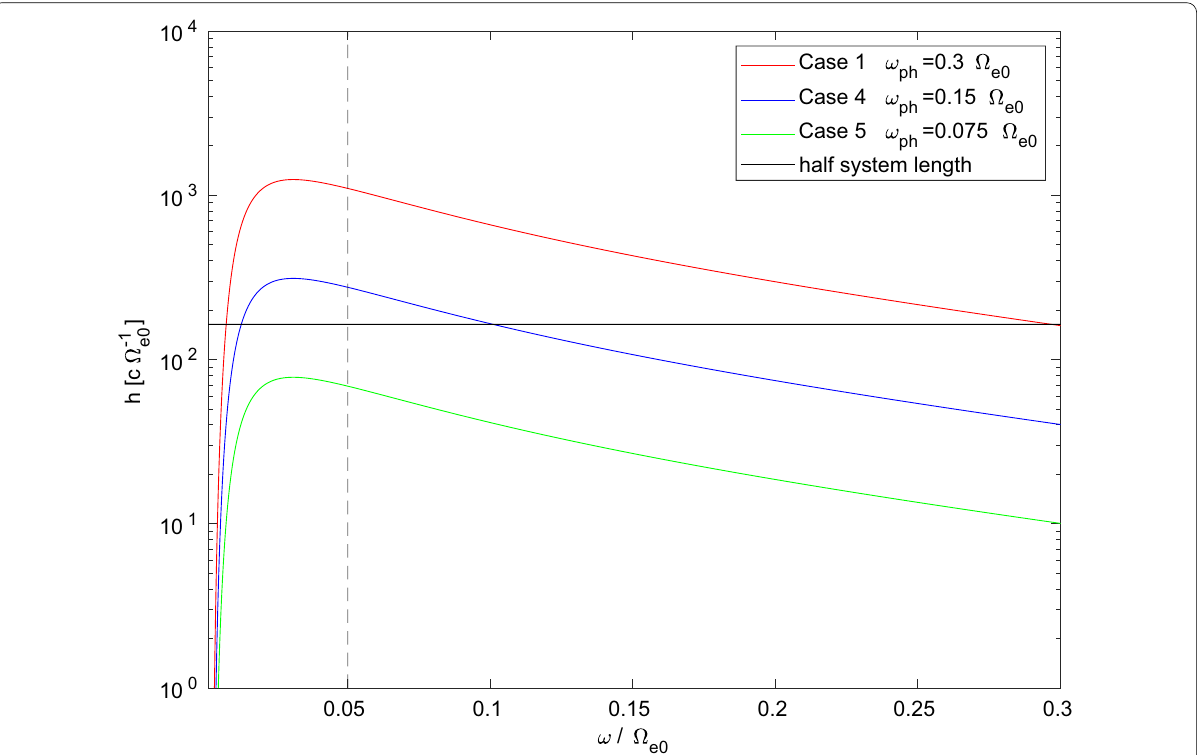
Fig. 9 Critical distances under different hot electron densities and half of the system length with the same parameters assumed in Fig. 8. Dashed line represents the typical frequency for plasmaspheric